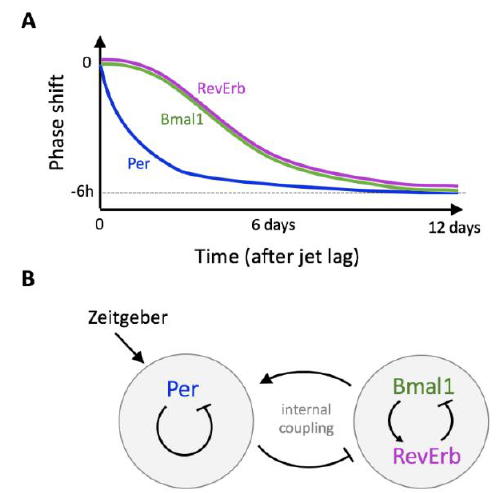
Figure 4. ( A ) Upon jet lag, not all clock genes resynchronize at the same speed [92,94]. ( B ) This transient twist can be explained by the internal desynchrony of the clock genes network